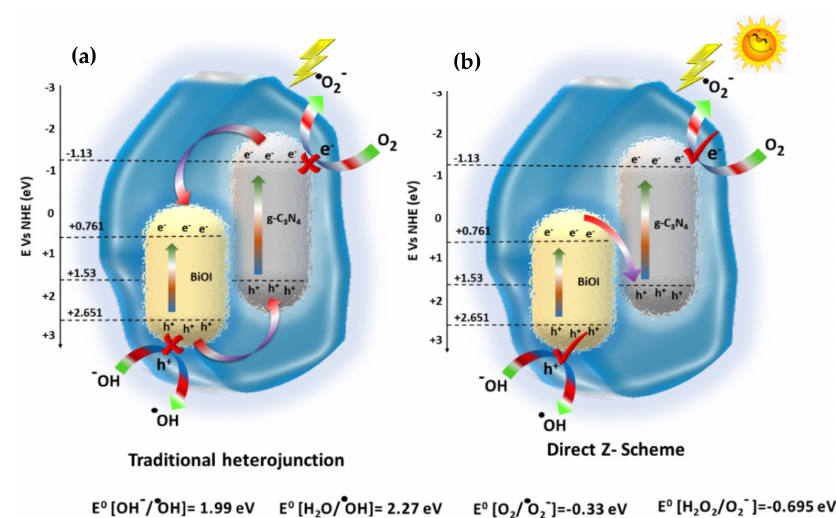
Figure 6. ( a ) Traditional heterojunction and ( b ) direct z-scheme for the GA-cl-poly(acrylamide)@C 3 N 4 /BiOI nanocomposite hydrogel.